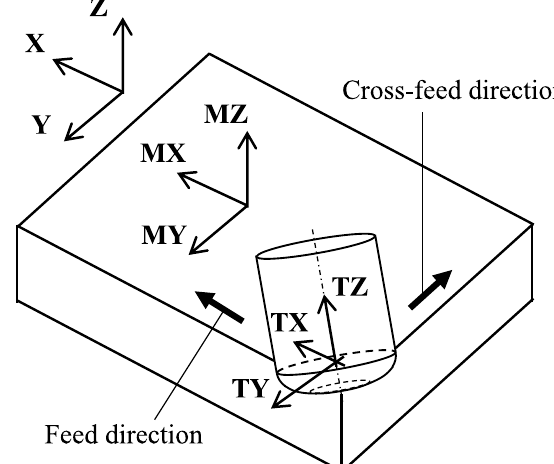
Fig. 1. Three coordinate systems in fi lleted end milling.